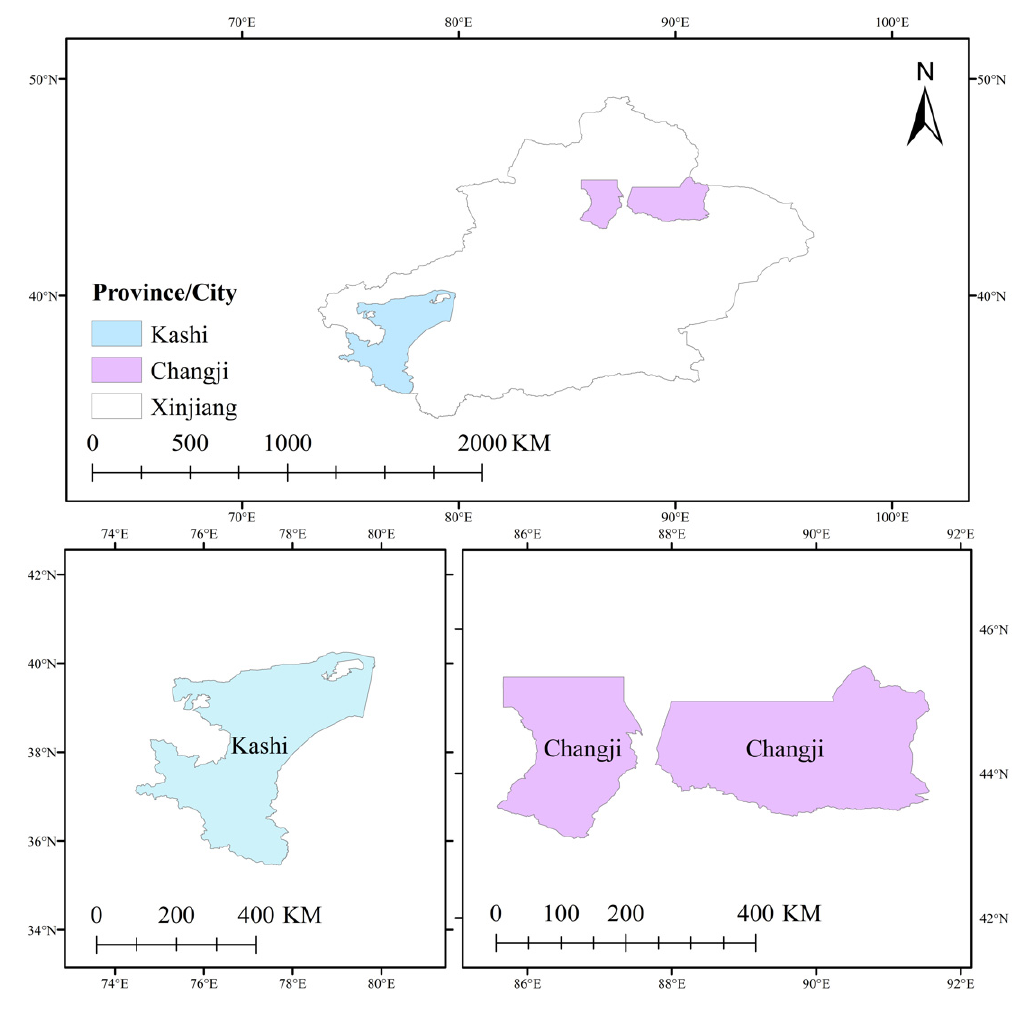
Figure 3. Field experiment